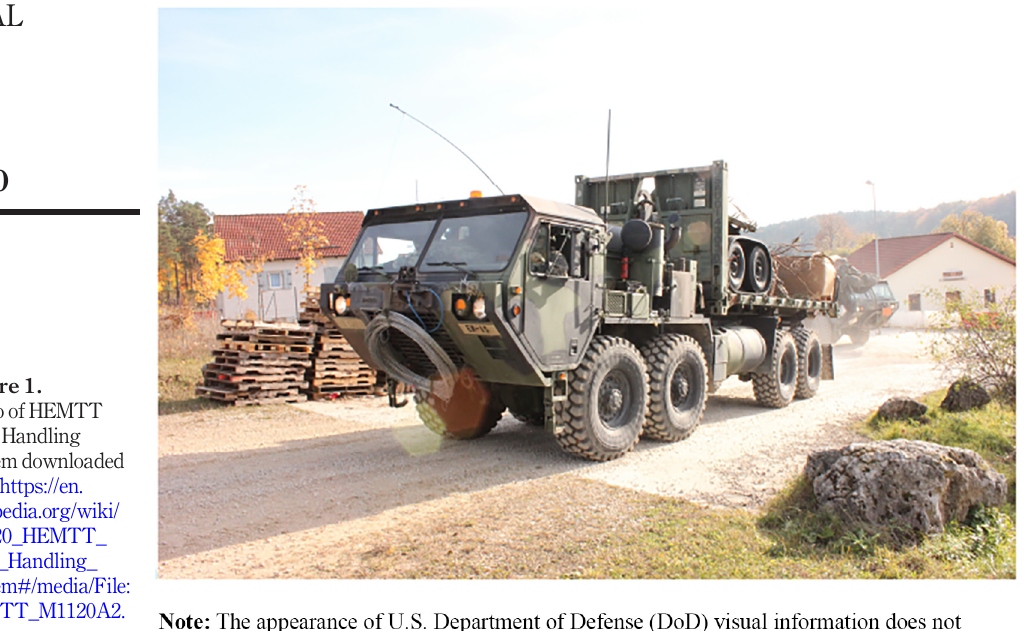
Figure 1. Photo of HEMTT Load Handling System